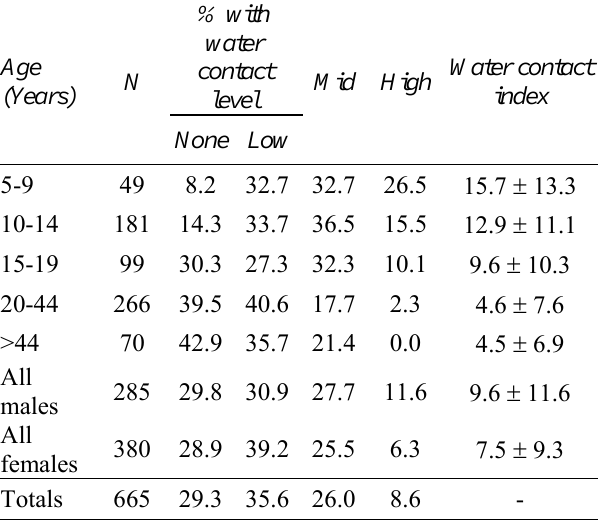
Table 3: Intensity of reported surface-water contact by age group and gender